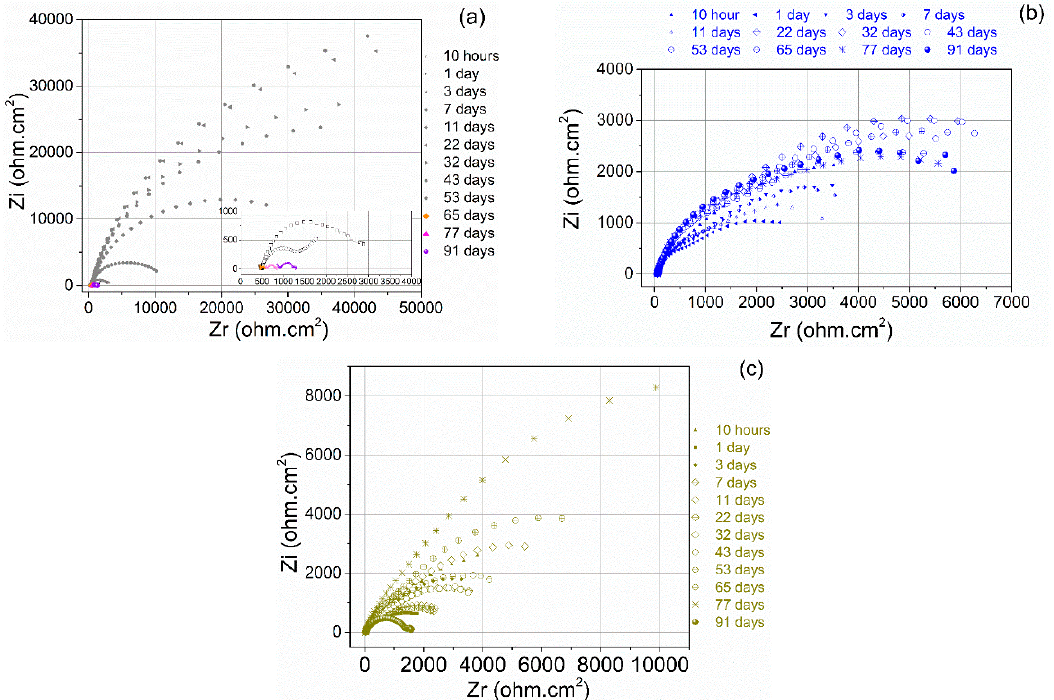
Figure 9. Impedance spectra (Nyquist plots) for the coatings after different immersion times in 0.1 M Na 2 SO 4 solution: ( a ) Al 5056, ( b ) Comps1 and ( c ) Comps2 coatings.